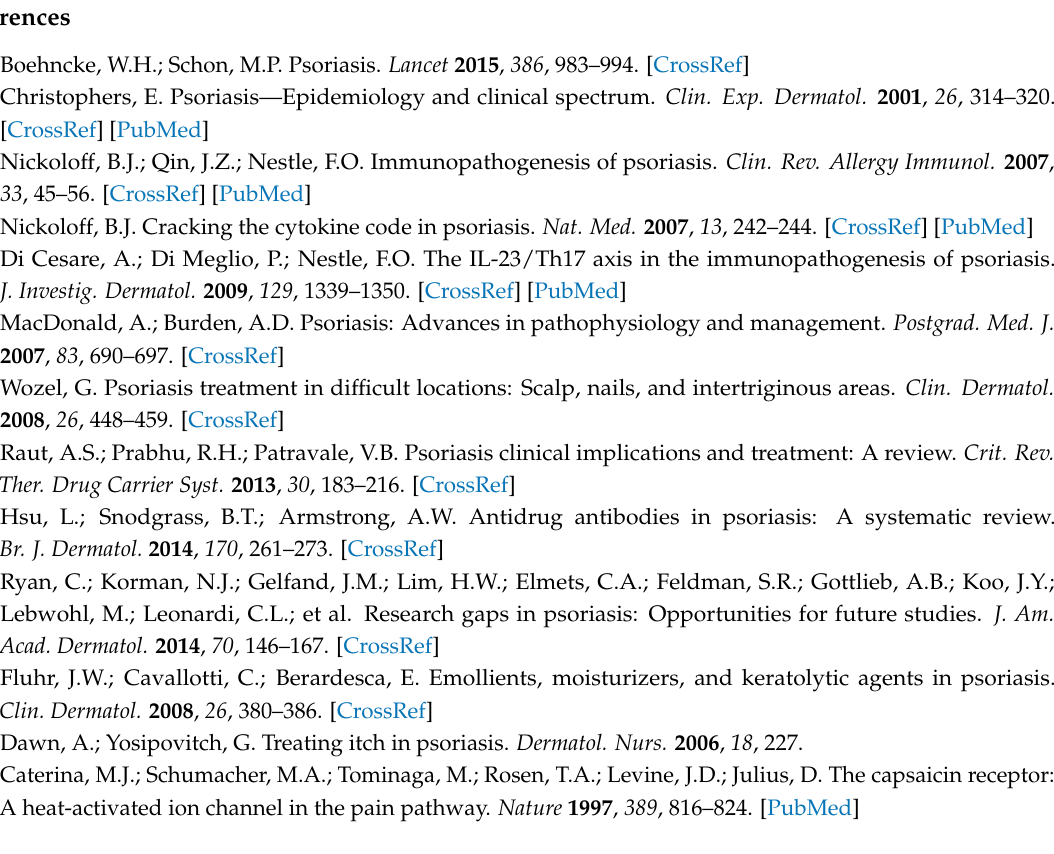
Figure S1: GC-MS chromatograms and calibration